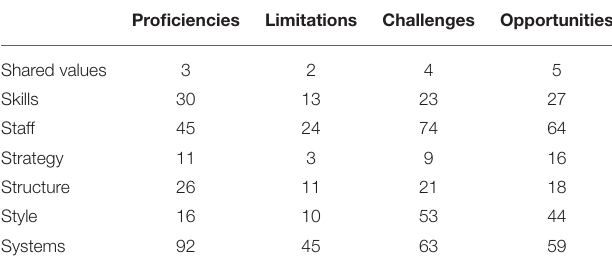
TABLE 1 | Summary of key themes’ coding emerging from the study: proficiencies, limitations, challenges, and opportunities across the 7S framework